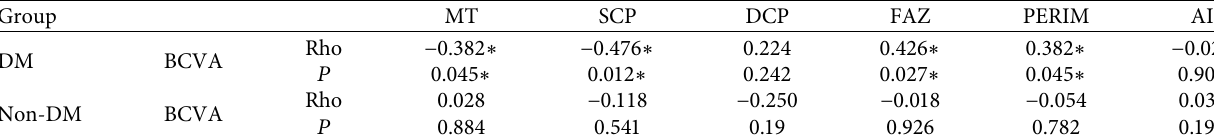
Figure 2: Pearson’s correlation analyses between the magnitude of the changes in MT, SCP, and DCP from baseline and related factors. All P > 0 . 05. DM, diabetes mellitus; HbA1c, hemoglobin A1c; BCVA, best-corrected visual acuity; MT, macular thickness; SCP, superficial capillary plexus; DCP, deep capillary plexus; CDE, cumulative dissipated energy; SBP, systolic blood pressure; DBP, diastolic blood pressure; TC, total cholesterol. Table 3: The result of Spearman’s correlation analysis.